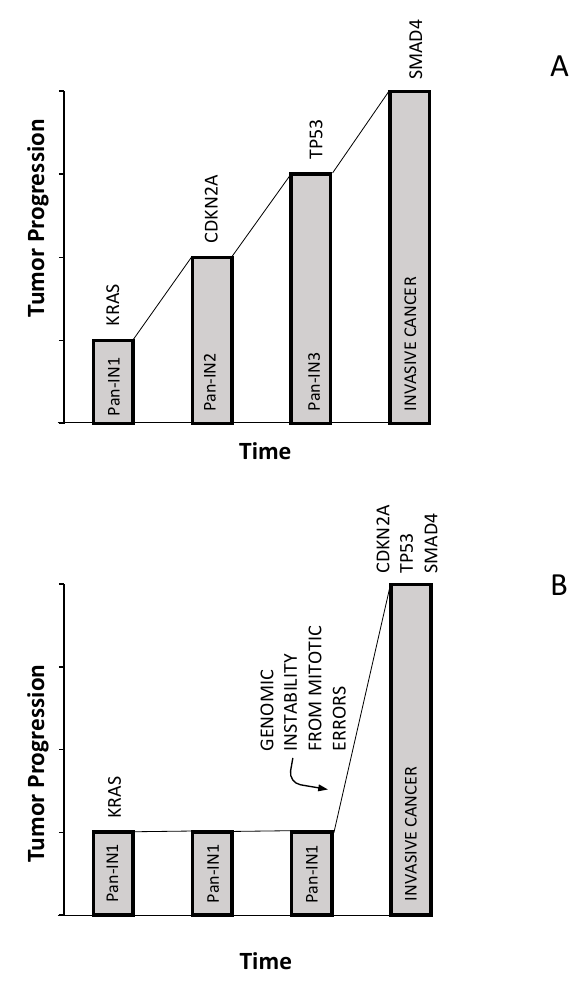
Figure 3. Two different models of PDAC development: ( A ) progressive accumulation of mutational events at various stages of tumor development; ( B ) after an initial transformation event, a unique chromothripsis event determines the rapid acquisition of additional mutations and copy number alterations. There is evidence that about 40% of PDACs develop following the A model and in about 60% of cases following the B model.